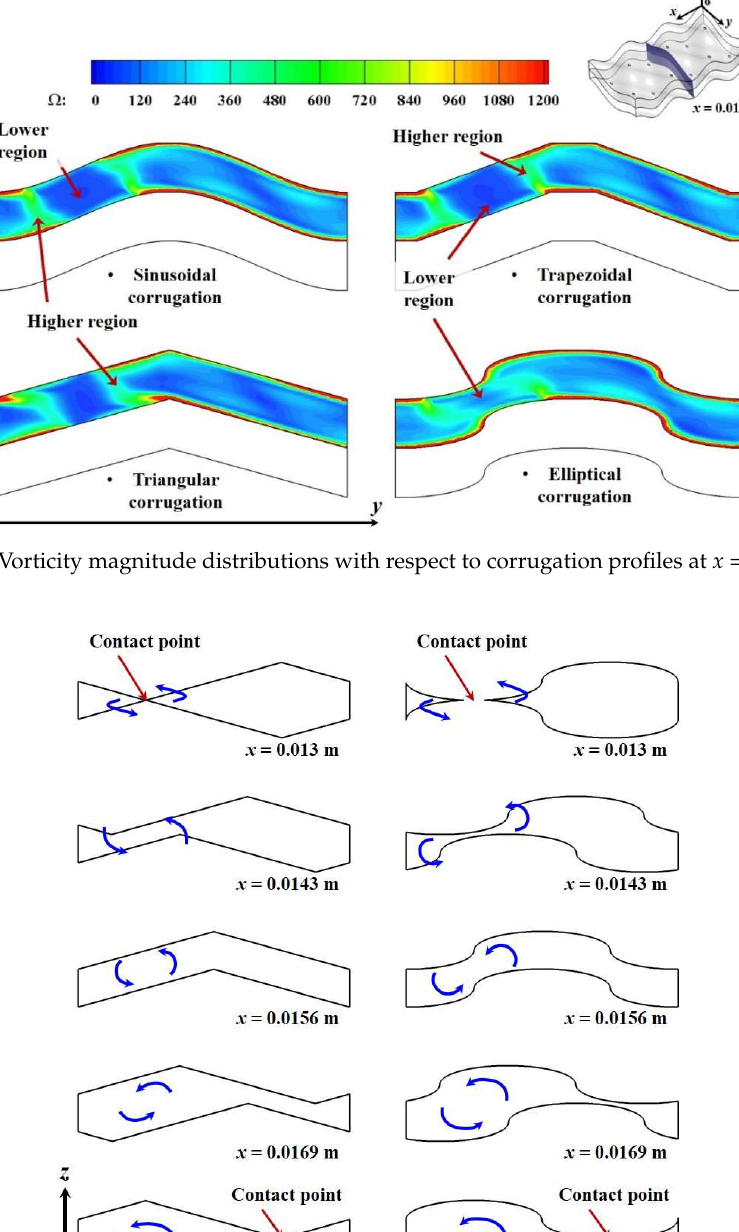
Figure 7. Velocity magnitude distributions for various corrugation profiles at x = 0.0156 m.